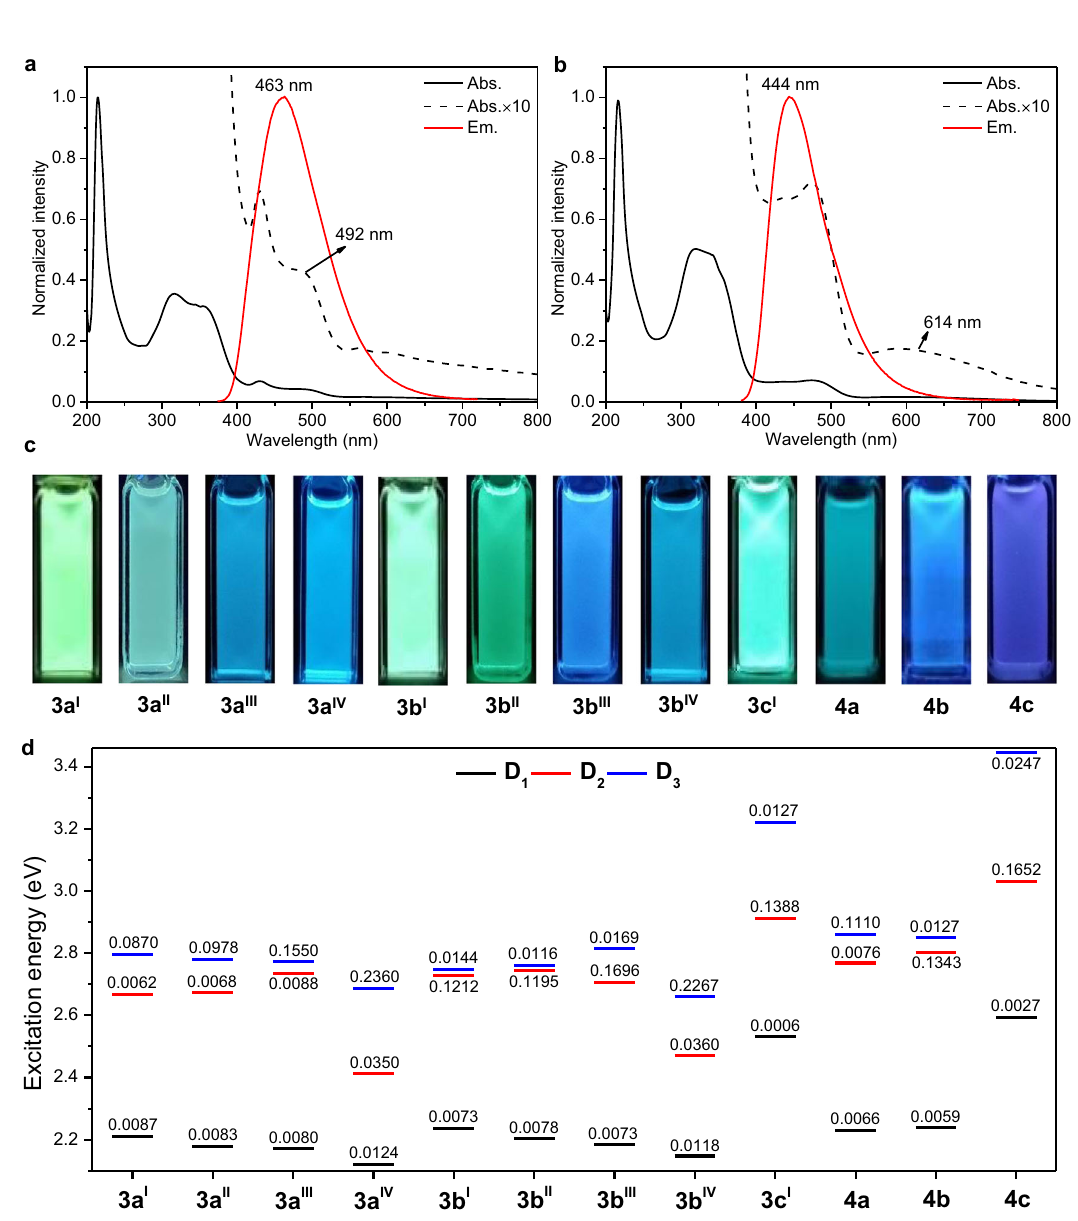
Fig. 5 | Emission spectra and DFT energies of the doublet (D 1 -D 3 ) states of the NHC – based radicals. a Absorption and emission spectra of 3a III in THF at room temperature. Enlarged portion of absorption spectra (10 fold) are shown. b Absorption and emission spectra of 3b III in THF at room temperature. Enlarged portion of absorption spectra (10 fold) are shown. c Photographs of the as-